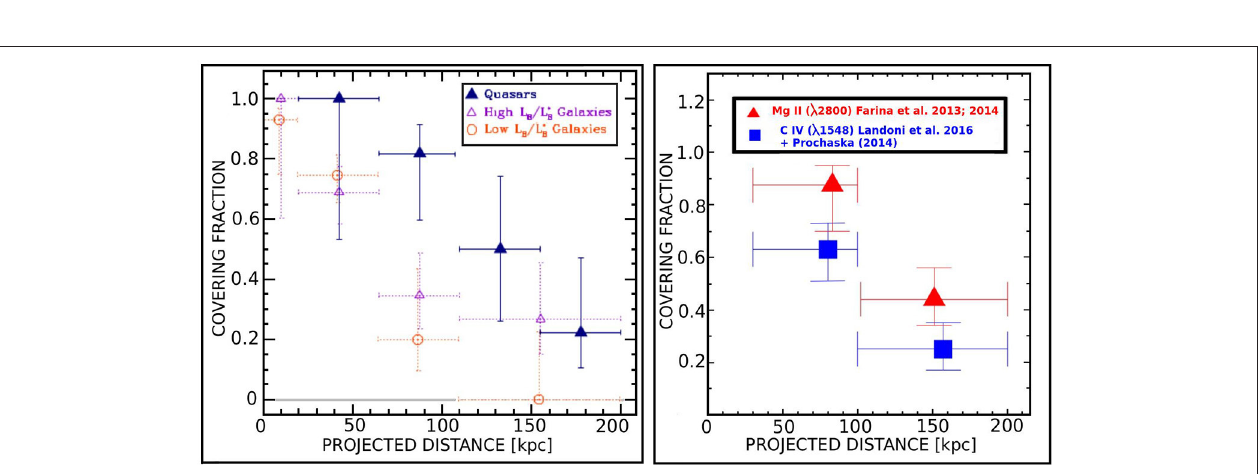
FIGURE 2 | Left : Comparison between quasars (Farina et al., 2014) and galaxies (Nielsen et al., 2013) of covering fraction of transversal absorption system of Mg II as a function of the projected distance. Right : Comparison of covering fraction of quasar halo for Mg II (red triangles) and C IV (blue squares) absorption lines. The covering fraction of Mg II is systematically higher than that of C